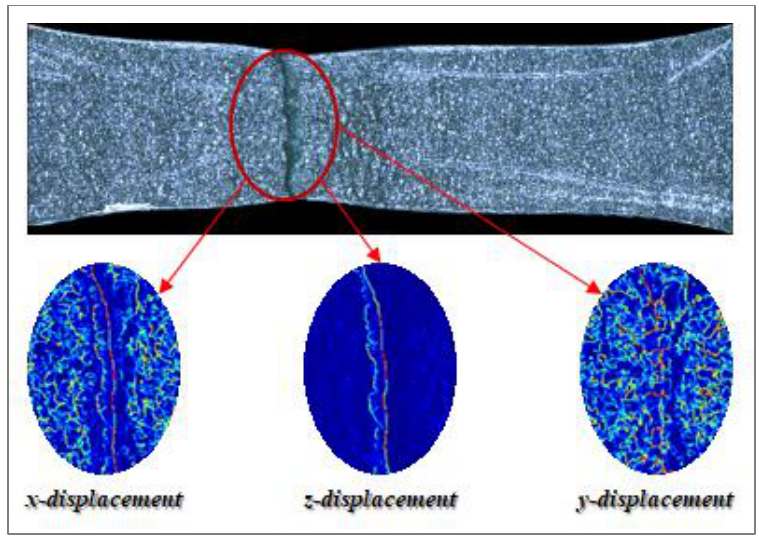
Figure 7. Illustration of local standard deviation of the hDIC displacement calculations around the break zone.